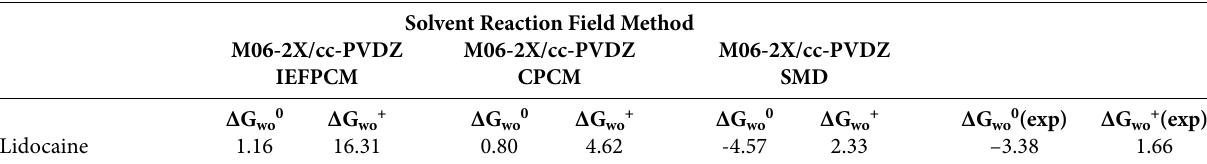
Table 3. Calculated free energies for the transfer of neutral and protonated lidocaine from water to n-octanol. ΔG wo0 and ΔG wo+ refer to the calculated free energies for the transfer of neutral and protonated local anesthetics from water to n-octanol. Experimental free energy values for the transfer of local anesthetics in their neutral and protonated form from water to n-octanol (ΔG wo0 (exp) and ΔG wo+ (exp), respectively) are calculated from experimental n-octanol water partition coefficients.